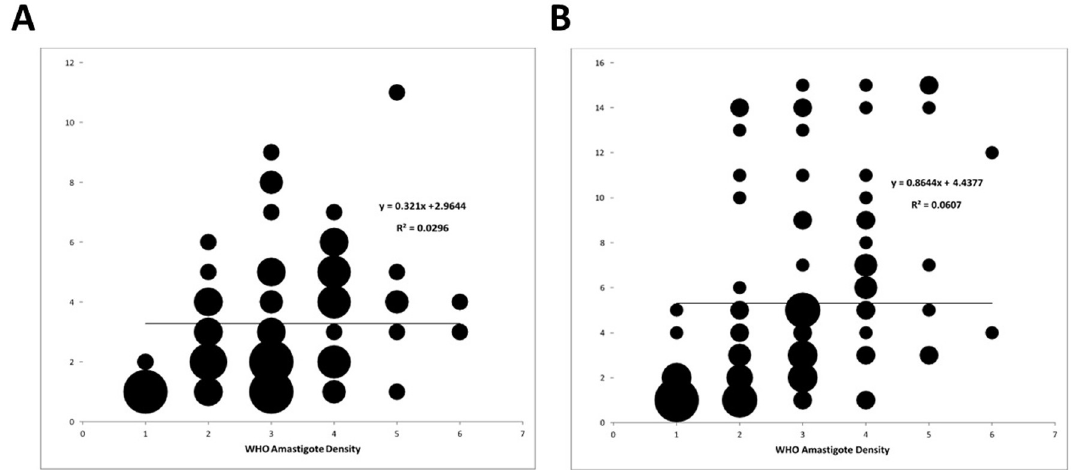
Fig 2. Modified CL Detect Rapid Test Intensity versus WHO Amastigote Density of Samples Collected by Scraping. The figure shows bubble charts for dental broach (A) and lancet scrapping (B). The Y-axis shows the CL-detect signal intensity (scale 0 to 15) whereas the X-axis shows the WHO amastigote density (scale 1–6).